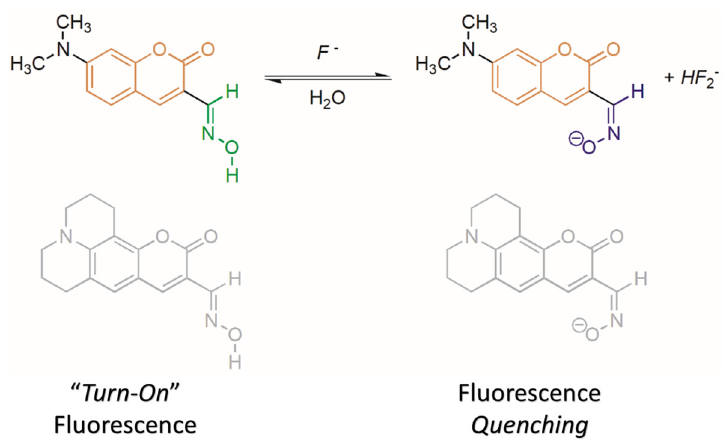
Scheme 2. Acid-base sensing mechanism for low-level water content determination in polar aprotic solvents using two-component coumarin oxime/F − chemosensors 1 /F − and 2 /F − .